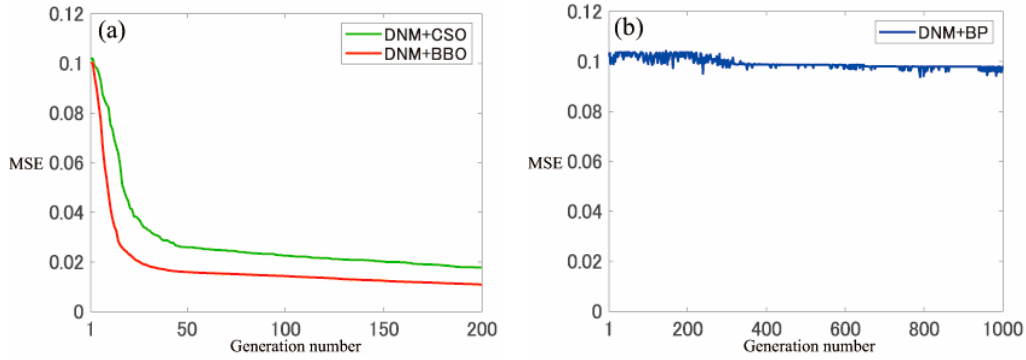
Figure 5. Convergence graphs of F3. ( a ) DNM + BBO and DNM + CSO, ( b ) DNM + BP.